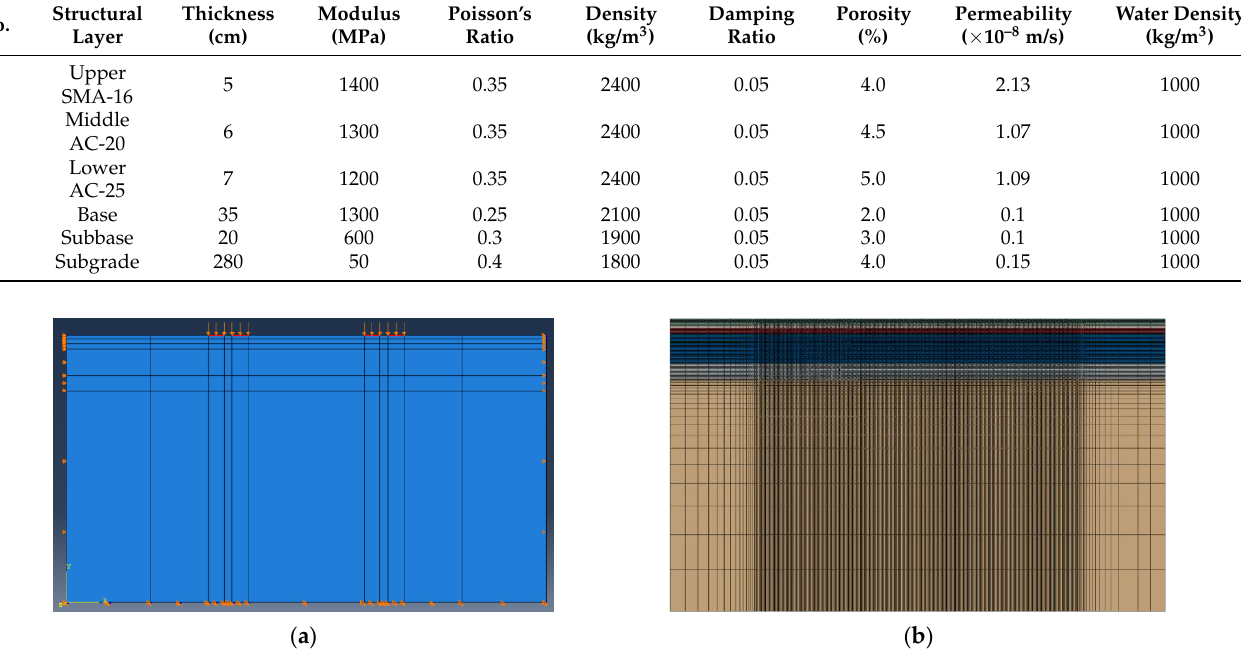
Figure 2. The FEM model of asphalt pavement structure: ( a ) Boundary conditions and load positions; ( b ) Meshing.